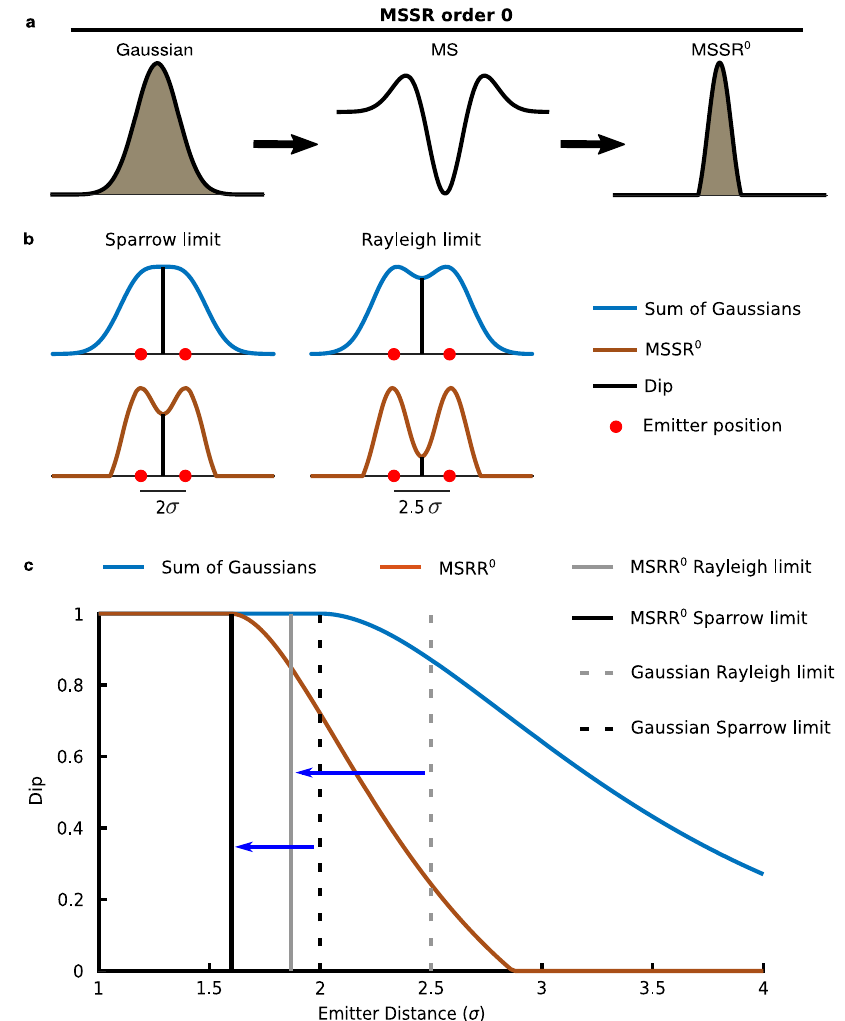
Fig. 1 | MSSR of zero order increases resolution by reducing the width of the spatial distribution of photons from simulated fl uorescent emitters. a The MS is applied to the initial Gaussian distribution of photons emitted by a point source (left) resulting in a MS graph (center). Application of further algebraic transfor- mations(seeSupplementaryNote5andSupplementaryFigS11(ii – iv))providesthe MSSR 0 distribution (right). b Sparrow and Rayleigh limits (blue, DL) and the cor- responding MSSR 0 transformation (brown) for two point sources. Red dots represent each emitter ’ s location. The dip is indicated by a vertical black line. The inter-emitter distance is expressed as σ -times their individual standard deviation